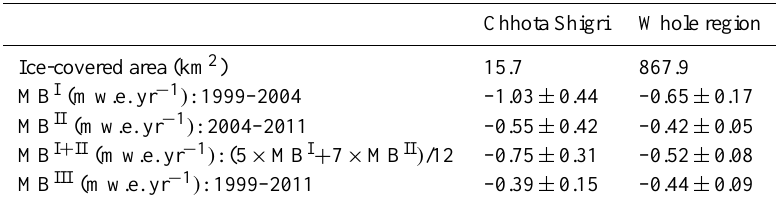
Fig. 6. Hypsometry of the ice-covered area of the whole region studied by Berthier et al. (2007), (left, 868km 2 in total) and the Chhota Shigri Glacier (right, 15.7km 2 ) and its sampling by the differential DEMs. The black curve corresponds to all pixels, the grey curve to DEM pixels that are valid in the 1999–2011 differential DEM, and the blue curve to the pixels that are valid in all DEMs (1999, 2004 and 2011). Those distributions show that the whole region is well-sampled in all cases, whereas for the Chhota Shigri Glacier, the 1999–2011 sampling is adequate but not the sampling by valid pixels in all three DEMs. Table 4. Geodetic MB during 1999–2004, 2004–2011 and 1999–2011. All values in this table are calculated using the correction and error analysis proposed by Gardelle et al. (2012a, b). For each time interval, all valid DEM pixels are used contrary to Table 5 below, in which only pixels which are valid simultaneously in all three DEMs are